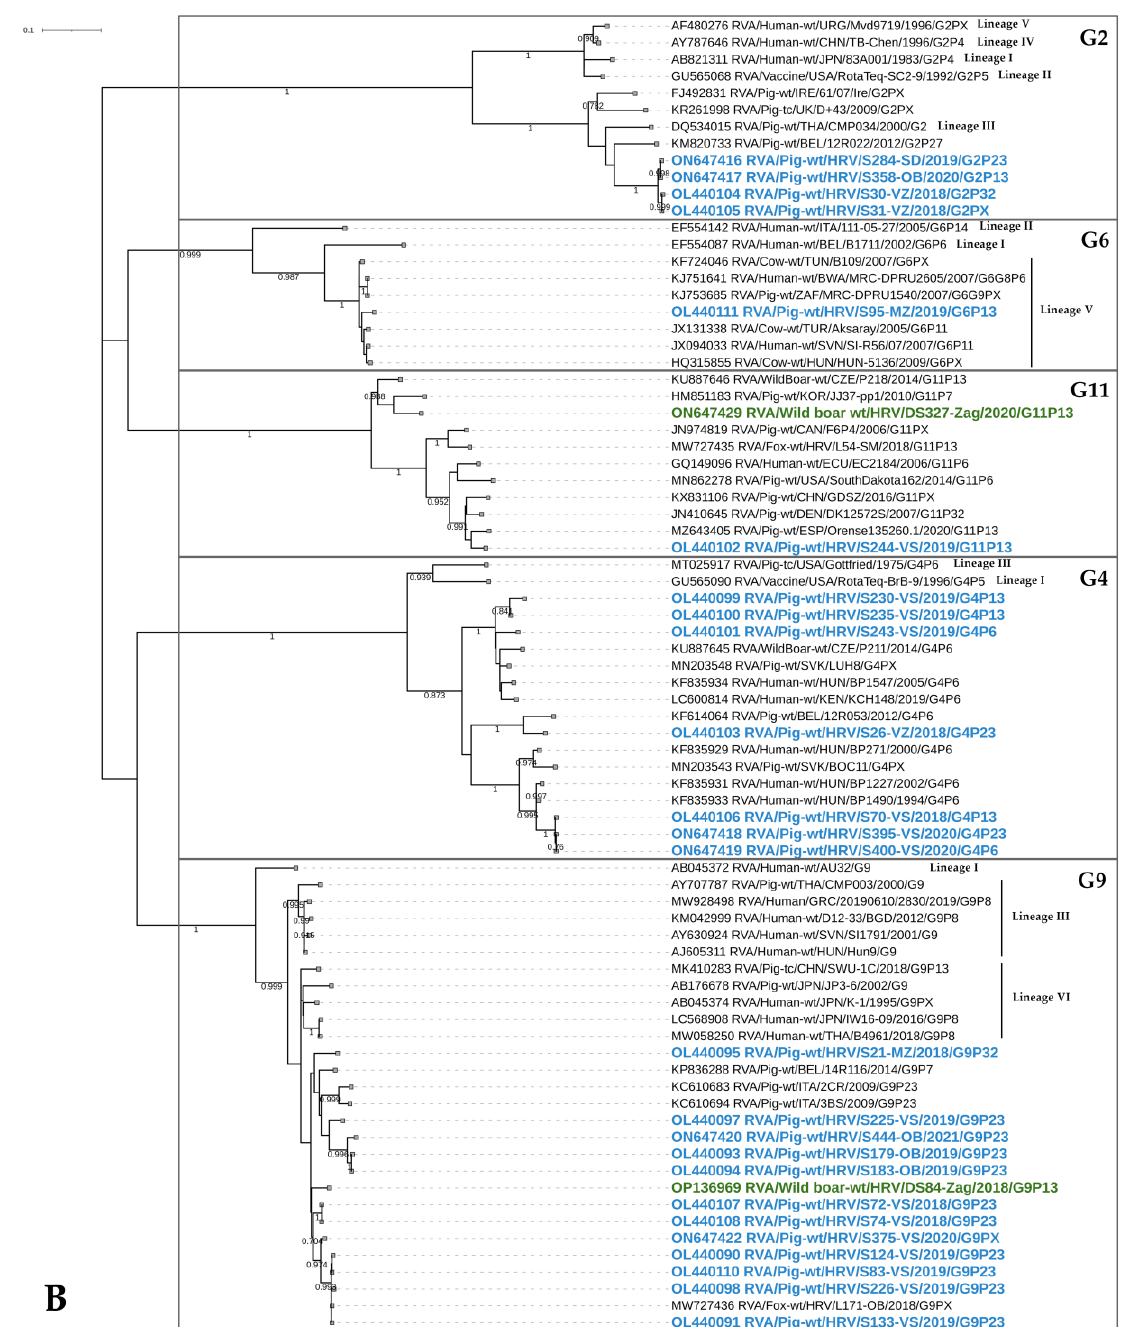
Figure 3. Phylogenetic relationship between RVA strains of G1, G3, G5 ( A ) and G2, G4, G6, G9, G11 ( B ) genotypes. The strains from the present study that were derived from domestic pigs and wild boars are marked in blue and green, respectively. The accession numbers of all strains, including referent strains from the GenBank, are designated within taxa. Based on the partial VP7 sequences (~800 nt), both trees were generated by the ML method and T92+G+I model in MEGA 11 software. The branching stability of each phylogenetic tree was assessed by 1000 bootstrap replicates (values indicated adjacent to the nodes if >0.7). The scale bar represents the number of substitutions per site. In displaying RVA strain nomenclature within taxa, the brackets for the P genotype were omitted for the sake of